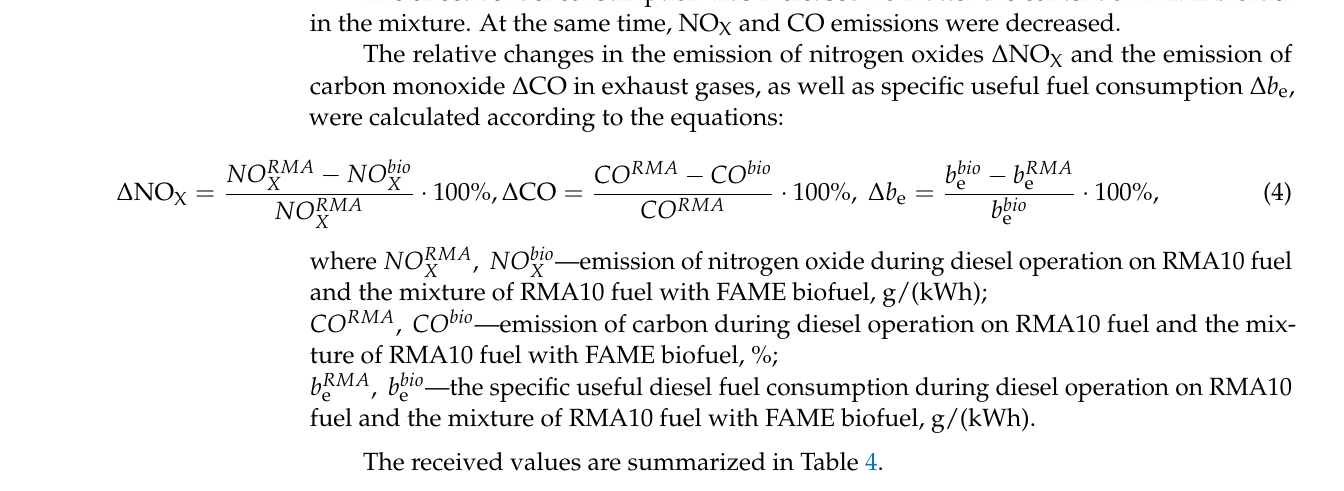
Table 4. Change in the relative performance of the 6N165LW Yanmar diesel